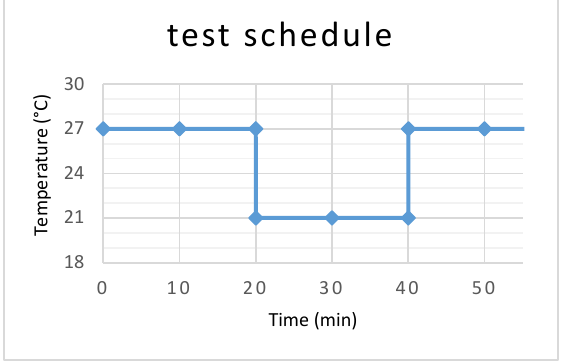
Figure 4. The 55-min schedule that all the subjects followed.